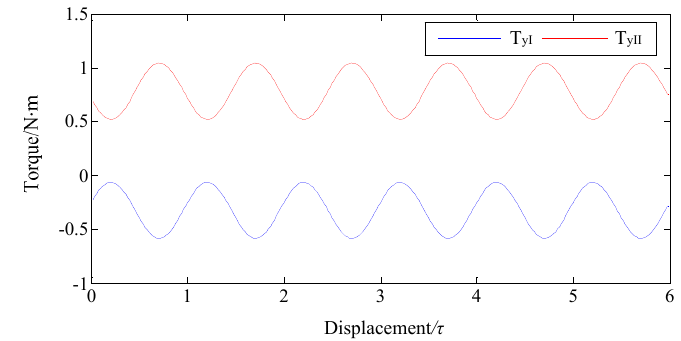
Figure 10. Additional torque generated by the unit I and the unit II.